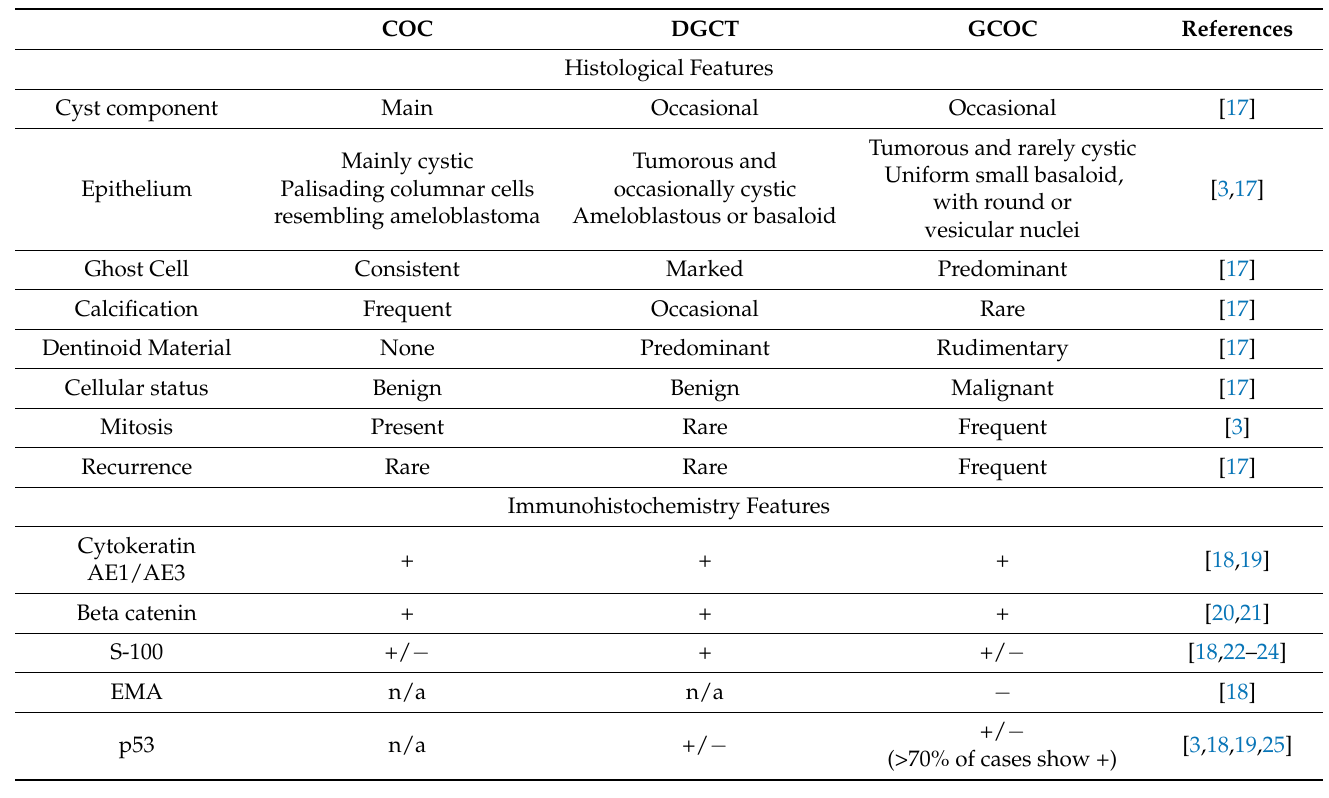
Table 1. Summary of histological and immunohistochemical features of COC, DGCT, and GCOC in humans. COC DGCT